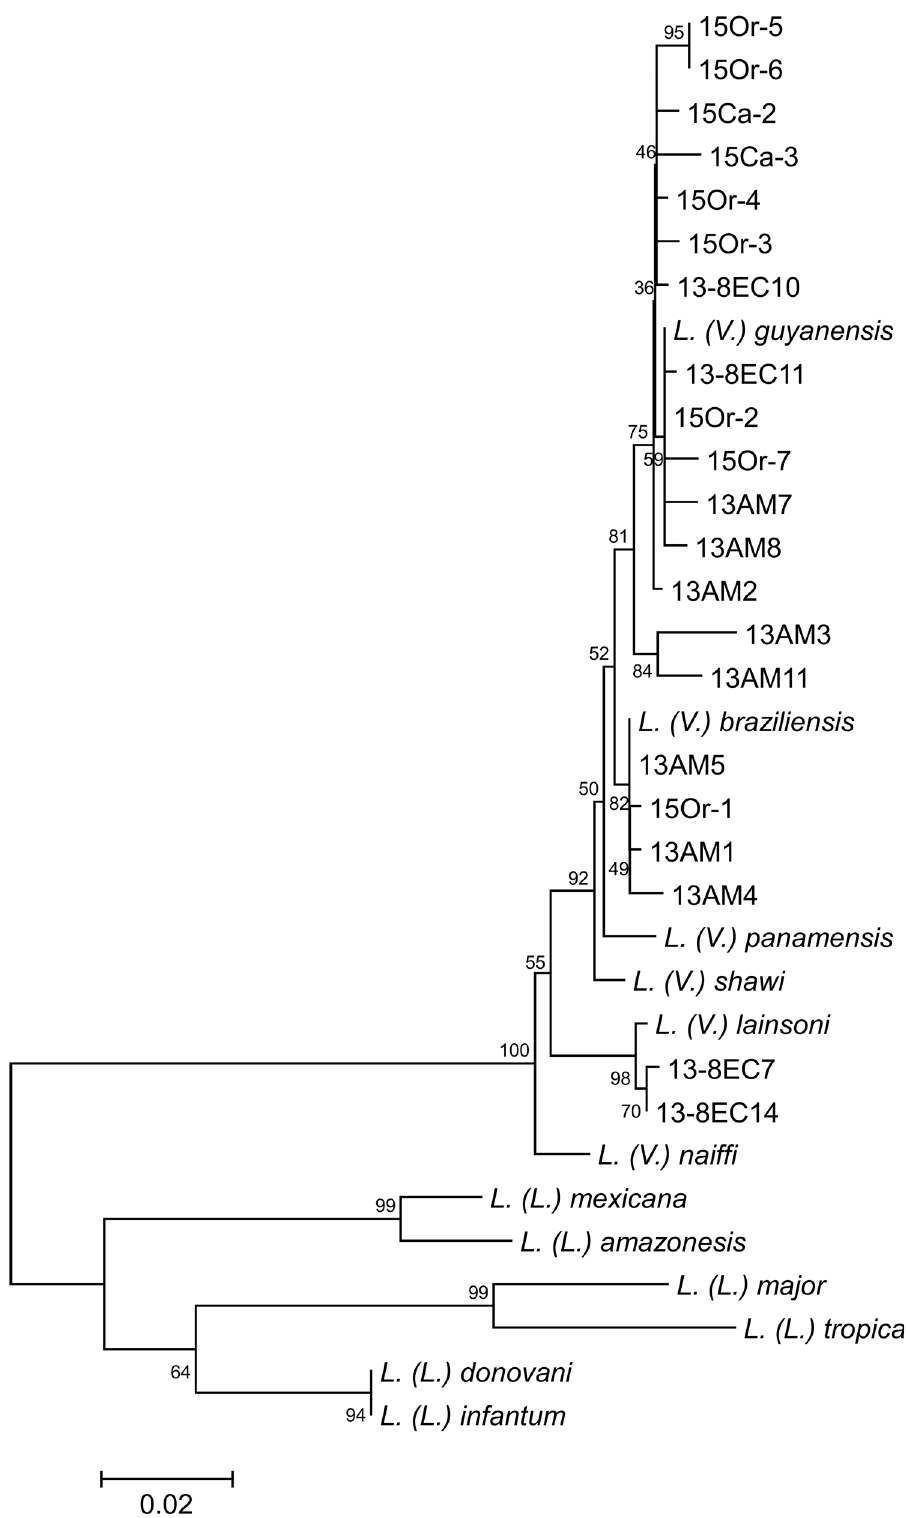
Fig 1. Phylogenetic tree of cyt b gene sequences among species. Leishmanial cyt b genes were amplified and sequenced from patients with cutaneous leishmaniasis (13-8EC7 – 13-8EC15, 13AM1